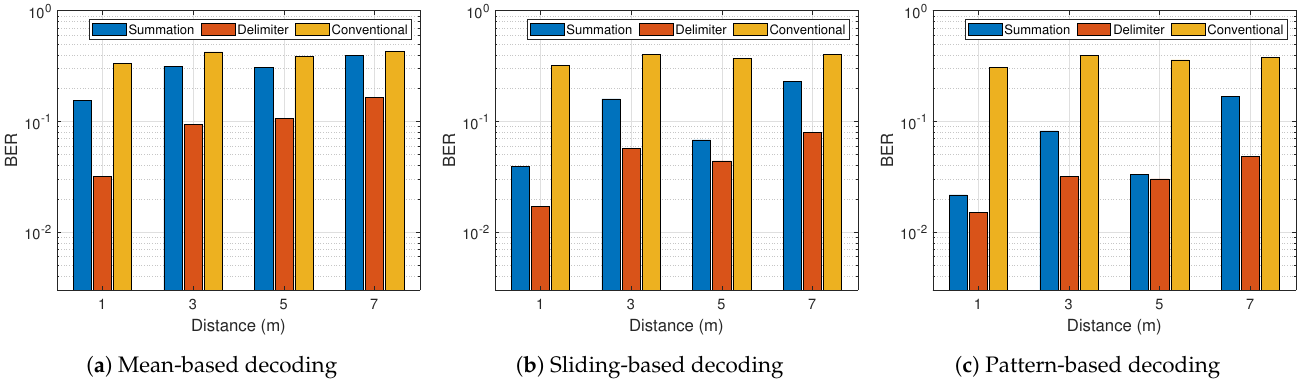
Figure 15. Bit-error-rate results for 500 kbps with three different decoding algorithms. The cumulative distribution function (CDF) graphs for the multi-filter designs and the classical method are seen in Figure 17 with the mean-based decoding algorithm. Two features can be inferred from the given plots: (1) the amount of data points captured and (2) the cumulative probability of BER at each point. It is obvious from Figure 17a having the least amount of data implying the conventional filter design is unable to identify (detect) most of the frames while the proposed schemes (Figure 17b,c) do a significantly good job at detecting as many frames as possible. The CDF, in addition, reveals that at 1 m, the BER of 0.01 or fewer accounts for the probabilities of 0.946 and 0.8125 for delimiter and summation designs, respectively, while the conventional design attained a probability of 0.2778 at the same BER. This trend cuts across the increasing distance for the experiments 1 m, 3 m, 5 m and 7 m. This conclusion affirms the earlier statement that the proposed designs are more efficient especially the delimiter